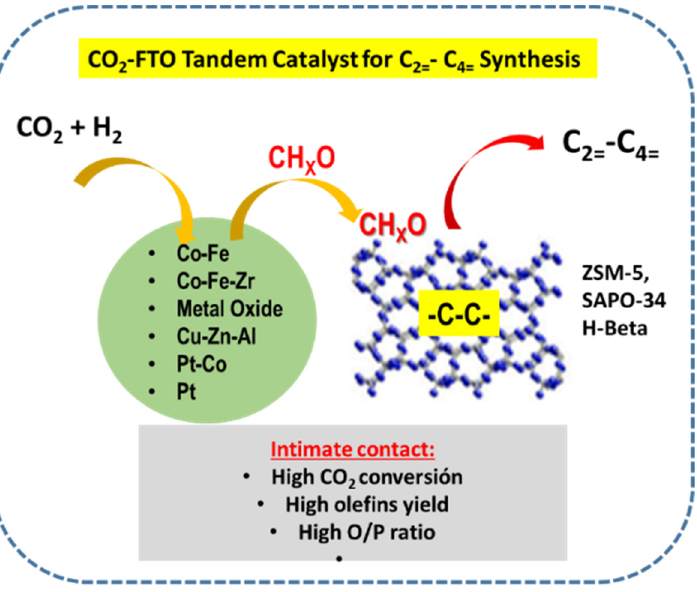
Figure 13. Visualization of the reaction mechanism of the direct hydrogenation of CO 2 to olefins over tandem catalyst.